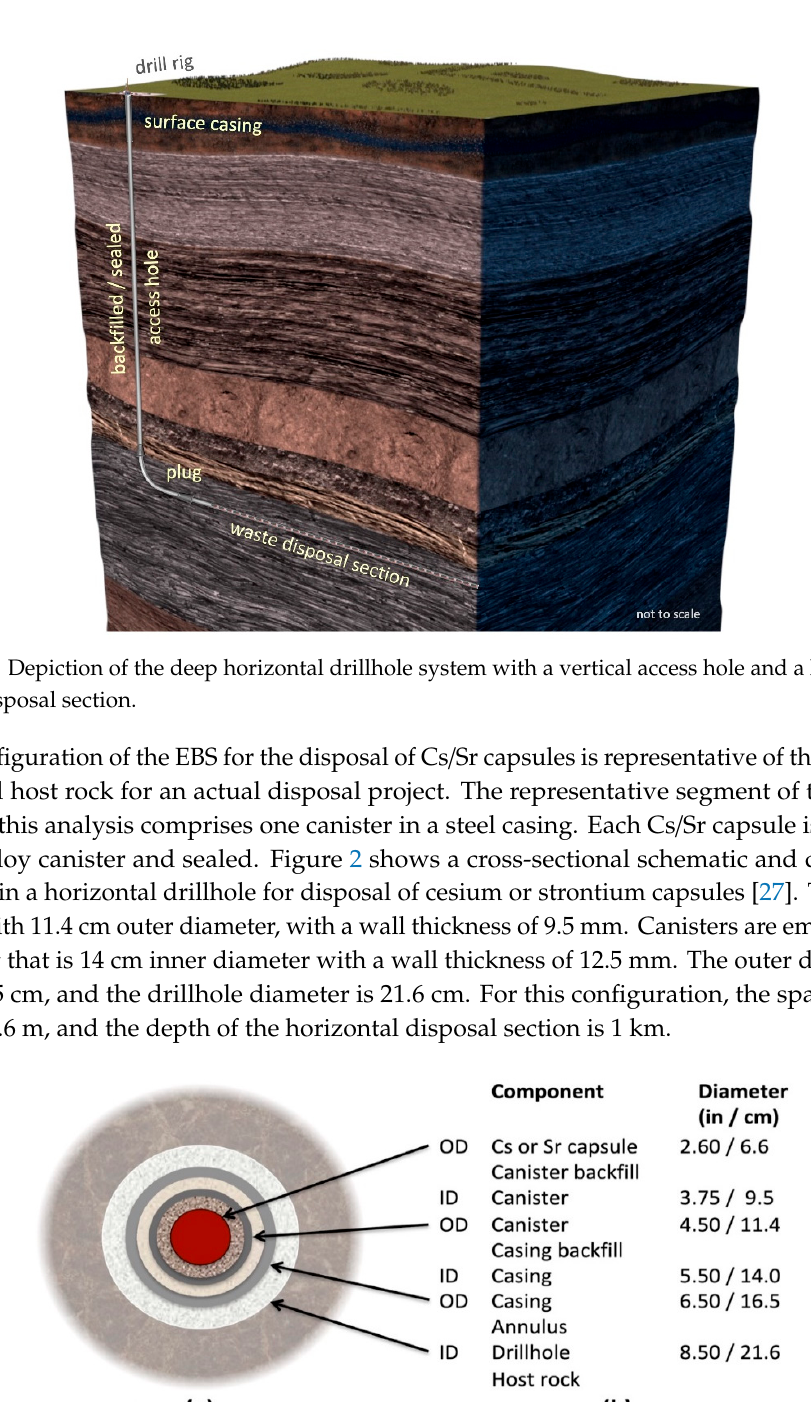
Figure 2. ( a ) Cross-sectional schematic of components in a horizontal drillhole used for the disposal of heat-generating cesium or strontium capsules; and ( b ) list of inner diameters (ID) and outer diameters (OD) of the components [27].